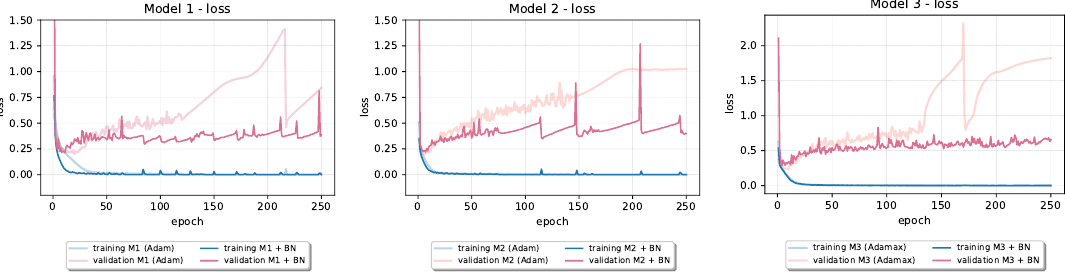
Figure 6. The effect of Batch Normalization on the loss of baseline models trained on Fashion-MNIST